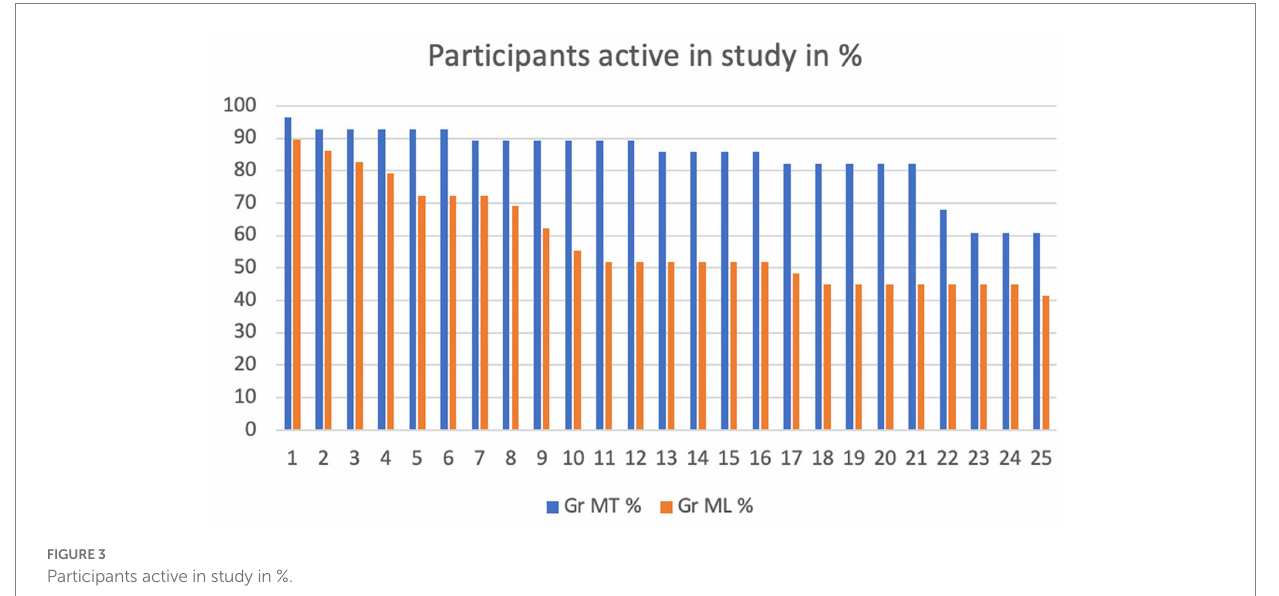
FIGURE 3 Participants active in study in